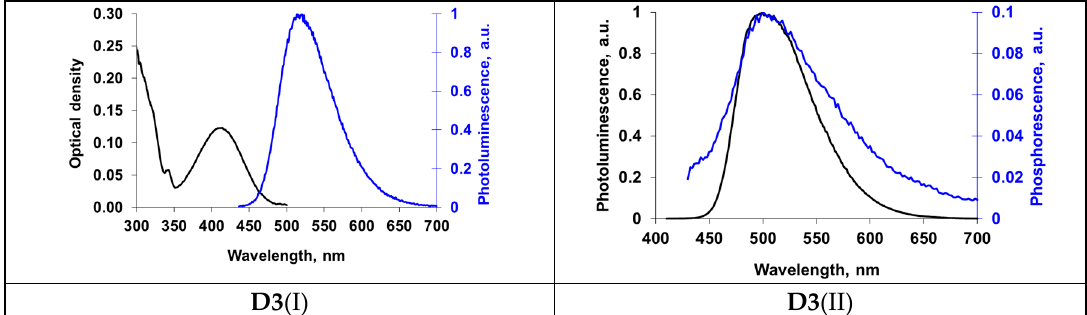
Figure 2. Optical spectra of D1 , D2 , D3 in m -xylene (concentration 10 − 5 M, optical length 1 cm, λ ex = 375–400 nm). ( I ) Absorption and photoluminescence at room temperature; ( II ) photoluminescence and phosphorescence (delay 1 ms) at 77 K.